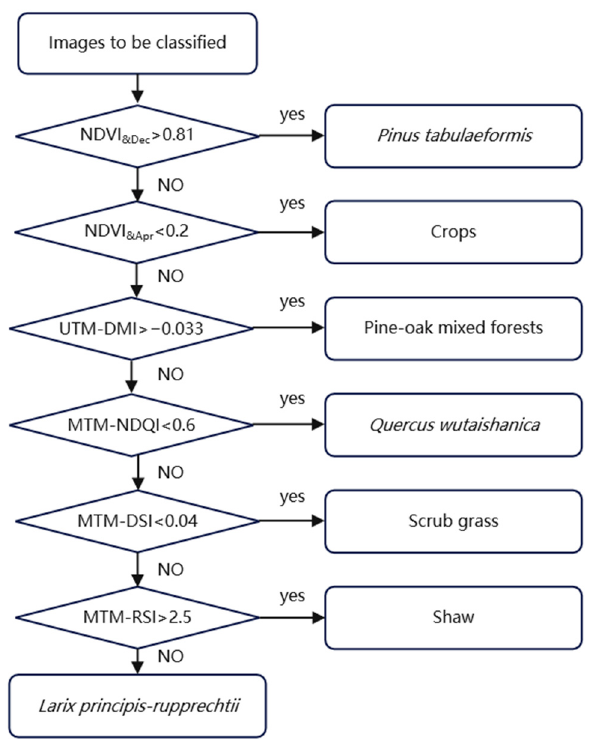
Figure 6. Model for knowledge decision tree.